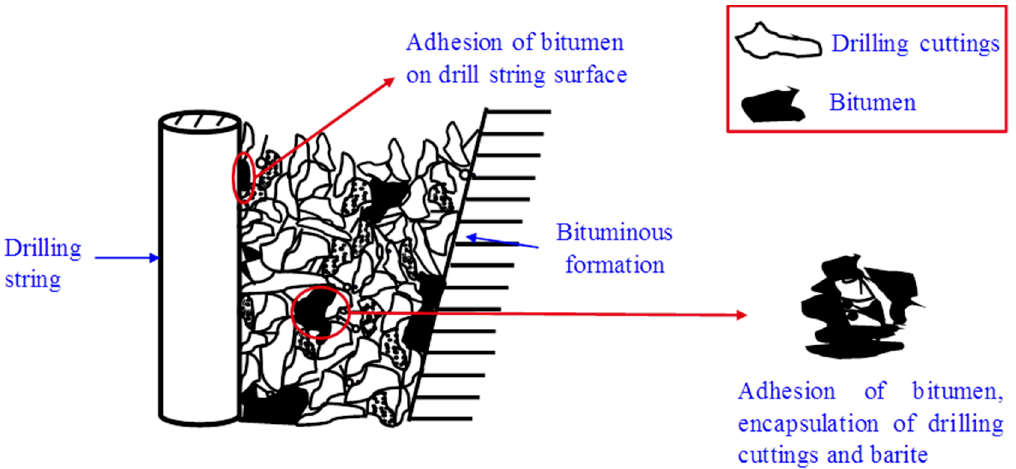
Figure 2. Schematic diagram of the formation of bitumen pollution and the sticking mechanism.